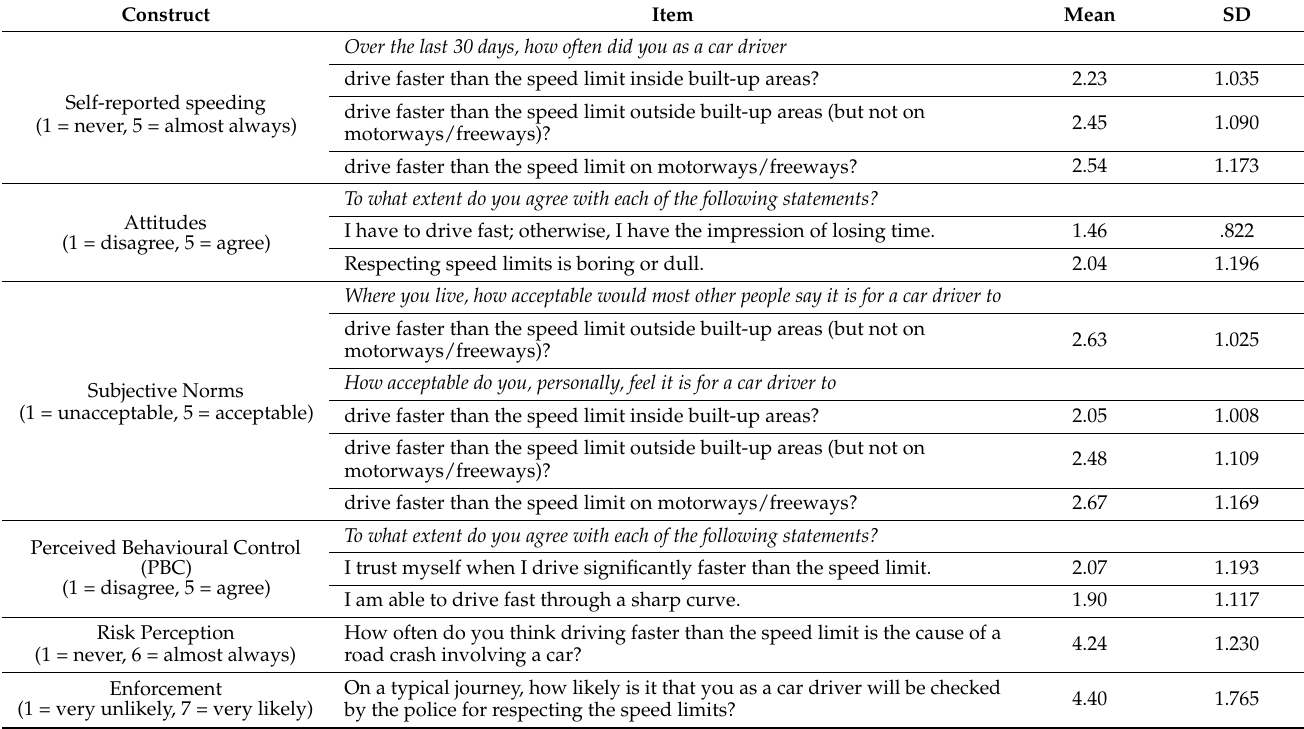
Table 3. ESRA speeding item scores and responses to TPB